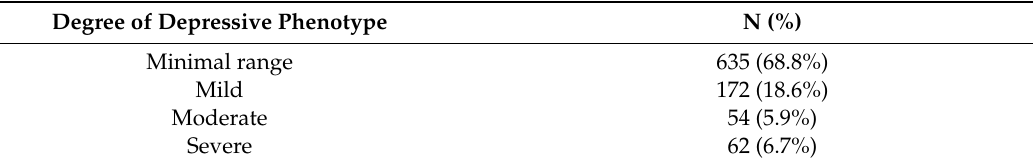
Table 3. Depressive symptoms among the study group.